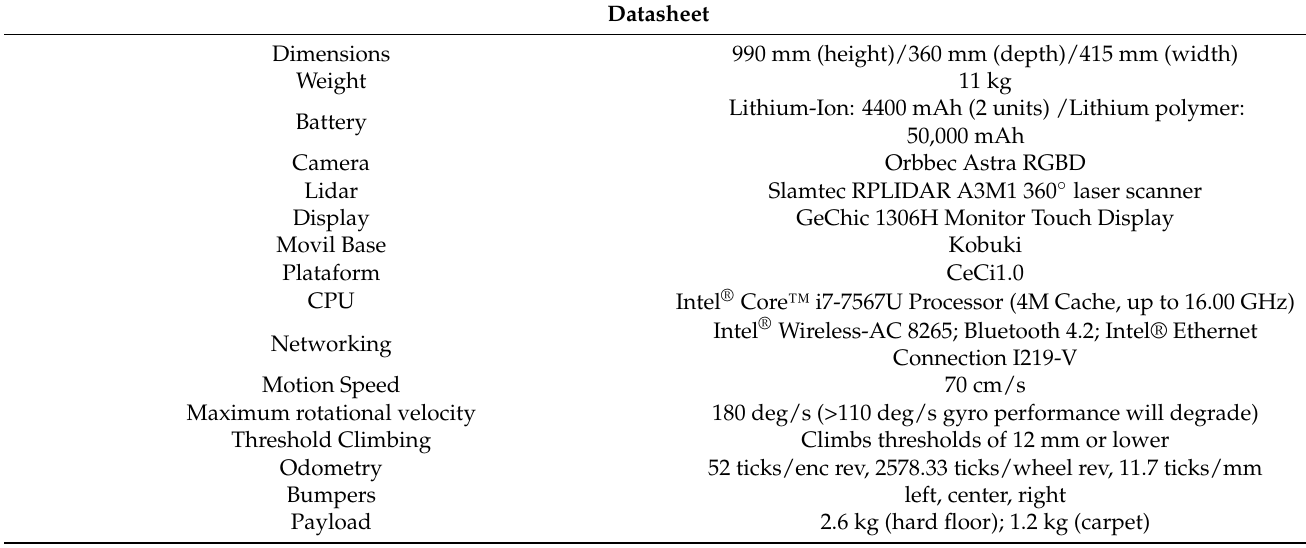
Table 6. Technical